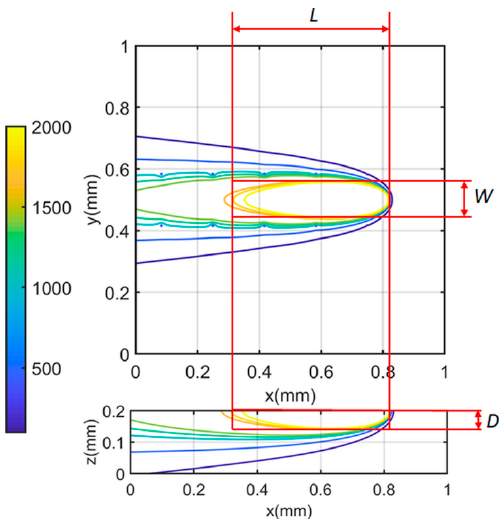
Figure 6. Calculation of molten pool dimensions from a three-dimensional temperature profile. L , W , and D represent the molten pool length, molten pool width, and molten pool depth, respectively.